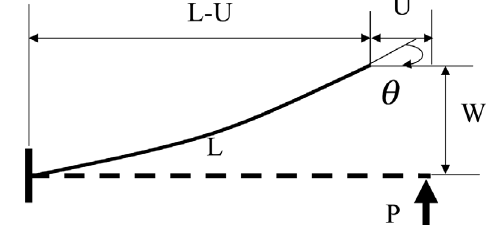
Fig. 4. A cantilever beam under tip point